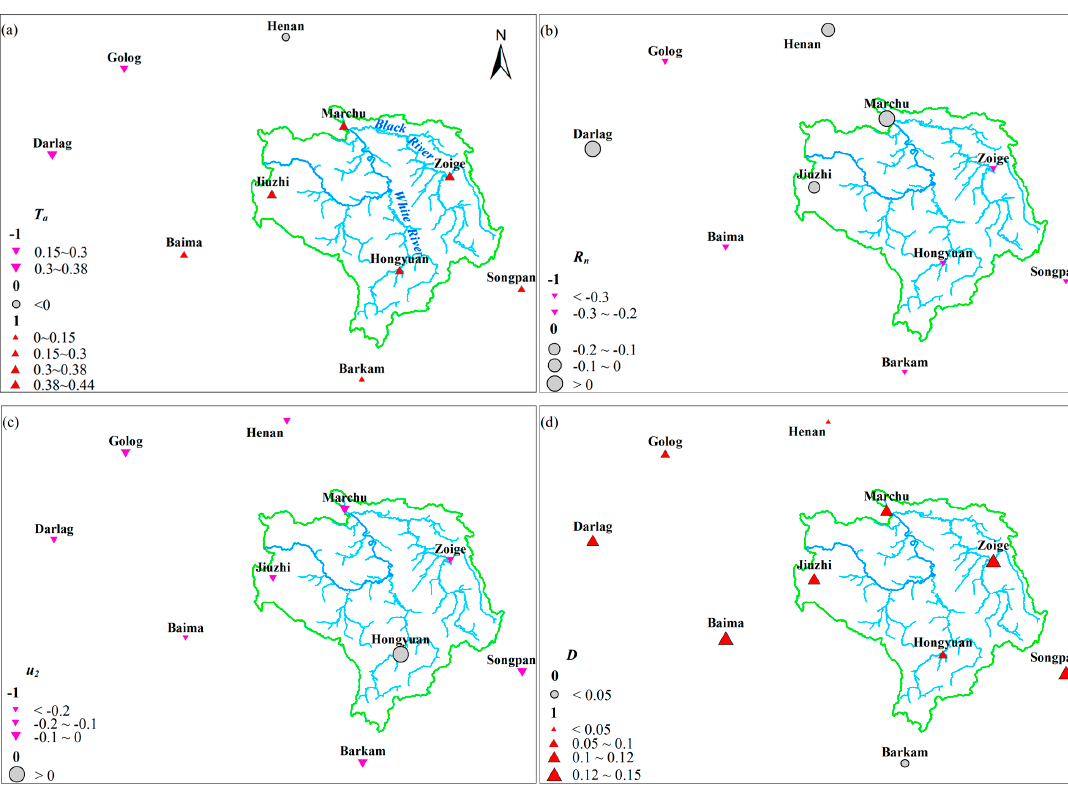
Figure 2. Annual trends in ( a ) T a , ( b ) R n , ( c ) u 2 , and ( d ) D in the Zoige wetland and its peripheral areas from 1969 to 2014, where − 1 represents a significant downward trend ( p = 0.05), 1 represents a significant upward trend ( p = 0.05), and 0 indicates the lack of a significant trend ( p = 0.05).